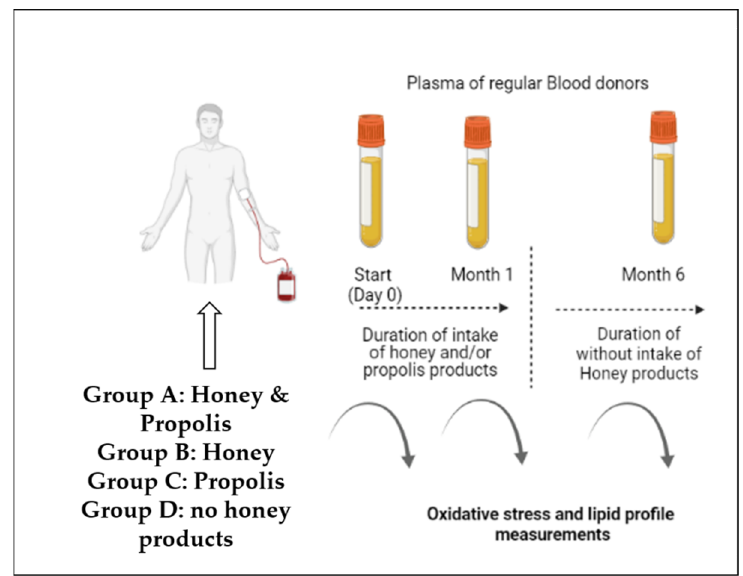
Figure 1. Flow chart of the experimental procedure.